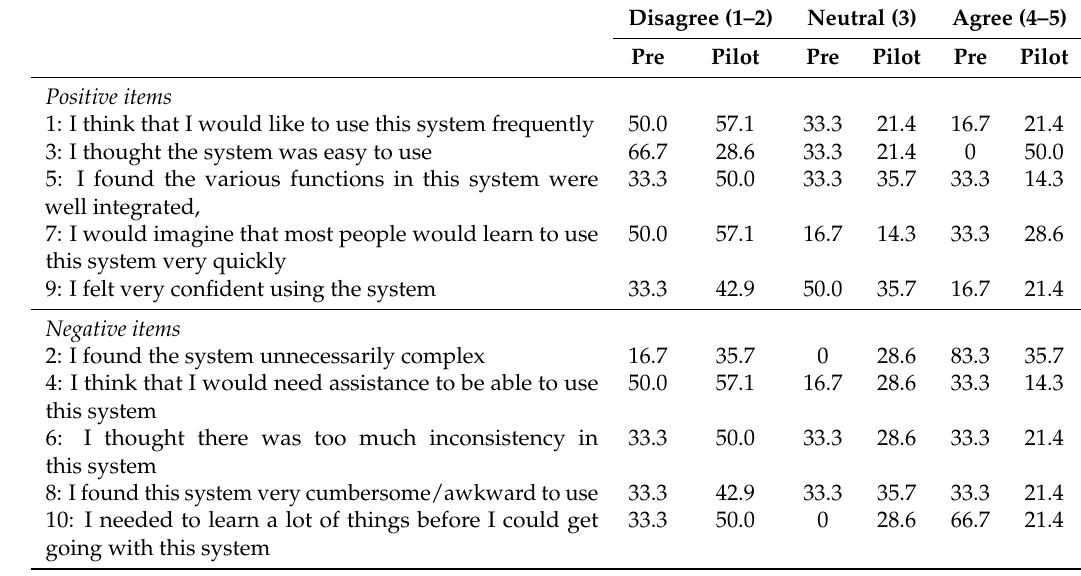
Table 4. Pre-pilot and pilot study usability (SUS) questionnaire scores (in